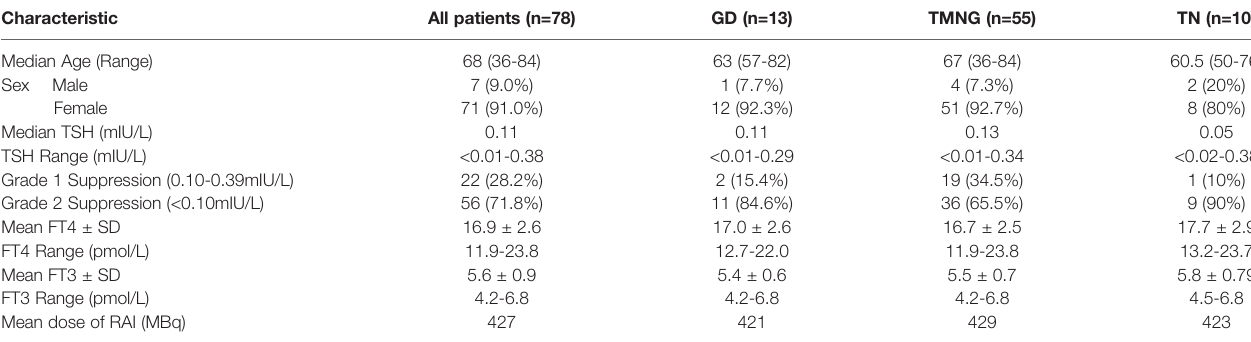
TABLE 2 | Baseline characteristics of patients with SCT.